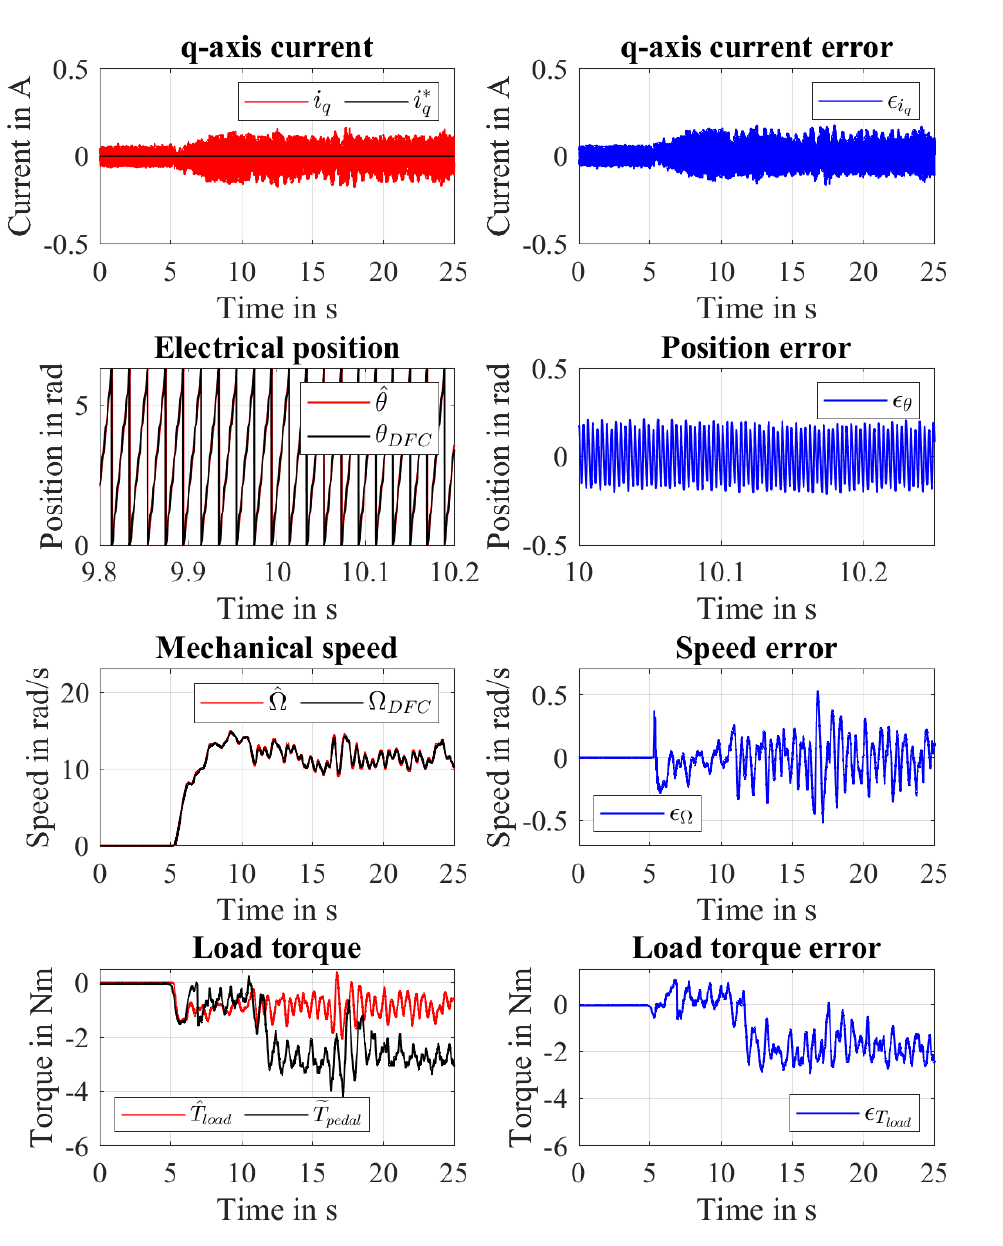
Figure 14. Experiment E4 : Applied pedalling torque with external torque